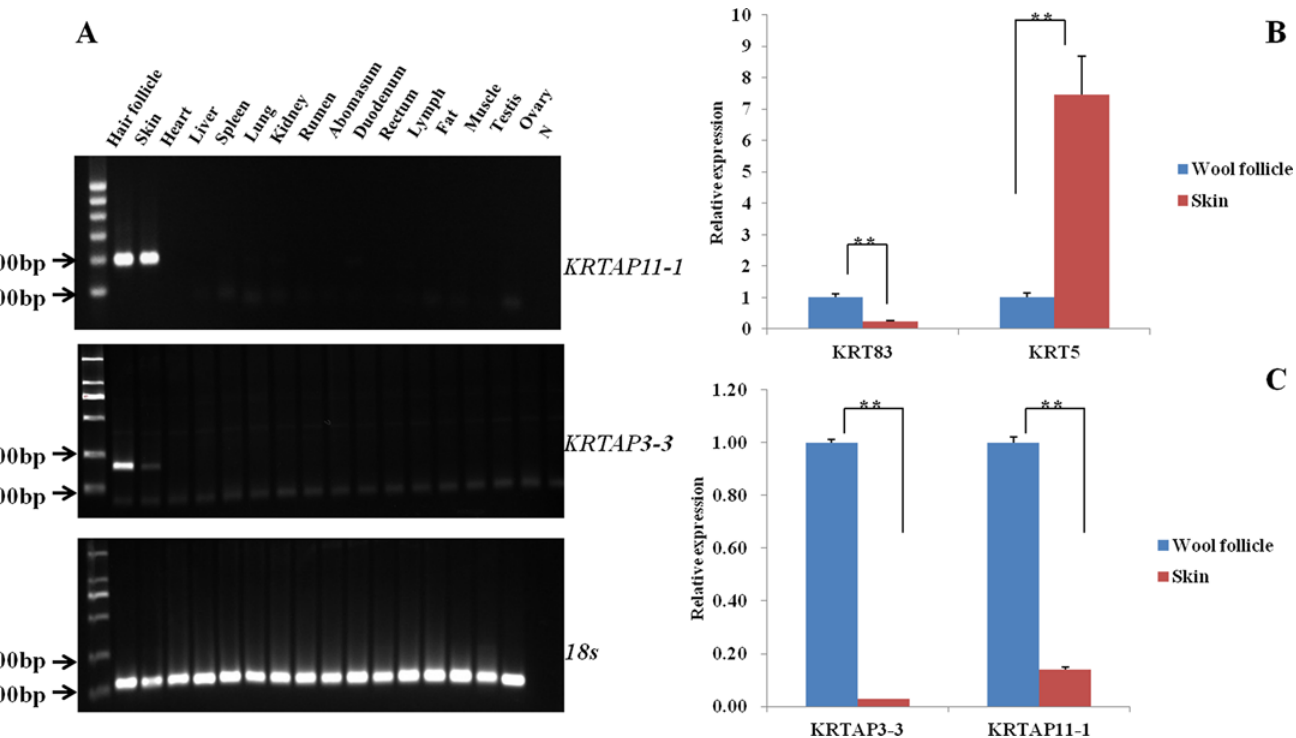
Fig 1. mRNA expression patterns of KRTAP3-3 and KRTAP11-1 in various tissues of the Tibetan sheep. (A) RT-PCR results of KRTAP3-3 and KRTAP11-1 in different tissues. Tissues: wool follicles, skin, heart, live, spleen, lung, kidney, rumen, abomasums, duodenum, rectum, muscle, lymph, testis and ovary. (B) qRT-PCR analysis of KRT83 and KRT5 in the wool follicles and skin of Tibetan sheep. (C) Relative expression of KRTAP3-3 and KRTAP11-1 in the wool follicles and skin of Tibetan sheep. Each experimental group contained three replicates, and qPCR was performed in triplicate for each sample. The data are presented as the mean ± SD (error bars); ** , P < 0.01; Student ’ s